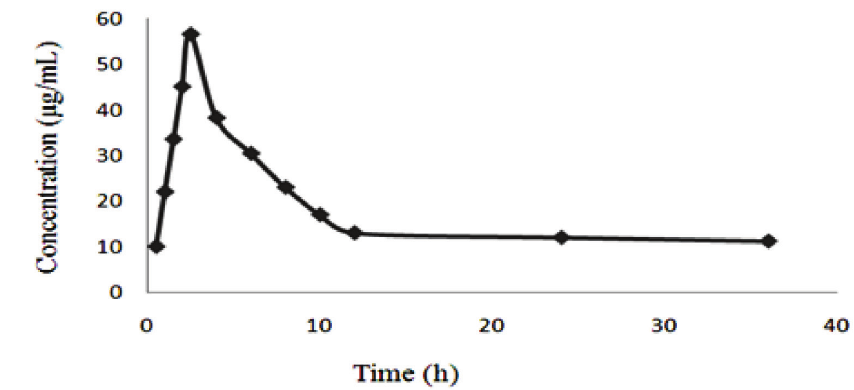
FIGURE 6 - Mean plasma concentration-time curve after a single oral dose of 5 mg venlafaxine TABLE VI - Non compartmental pharmacokinetic analysis after a single oral dose (5 mg) administration Pharmacokinetic parameters